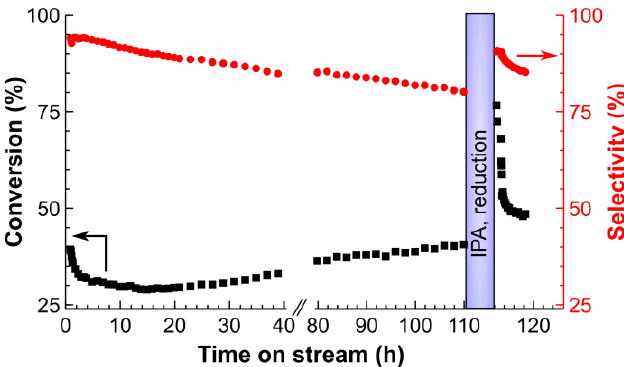
Figure 10. The stability test of the 5 m tube reactor coated with a 12 wt % Pt/SiO 2 catalyst. Reaction conditions: H 2 flow rate: 3 mL min −1 , liquid flow rate: 0.2 mL min −1 . CAL concentration: 0.8 M in IPA, pressure: 15 bar and temperature: 90 °C. Reduction was performed in the flow of isopropanol (1 mL min −1 ) and H 2 flow rate (3 mL min −1 , STP) for 10 min. The duration of the reduction step on the plot is exaggerated for the presentation purposes.